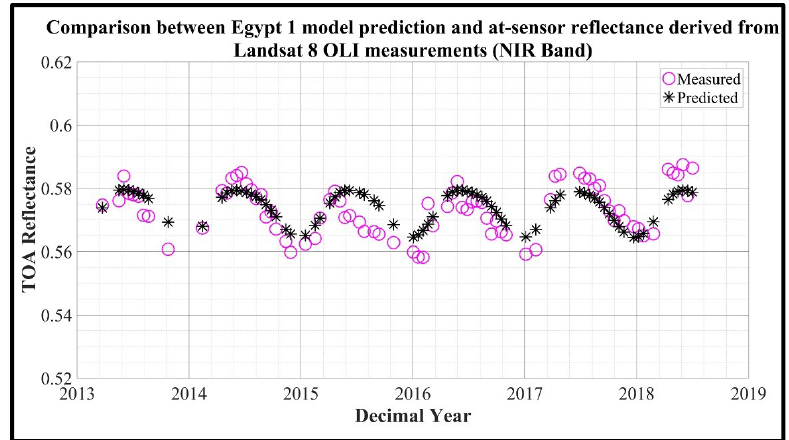
Figure 11. L8 OLI observations of Egypt 1(circle) and model prediction (asterisk).